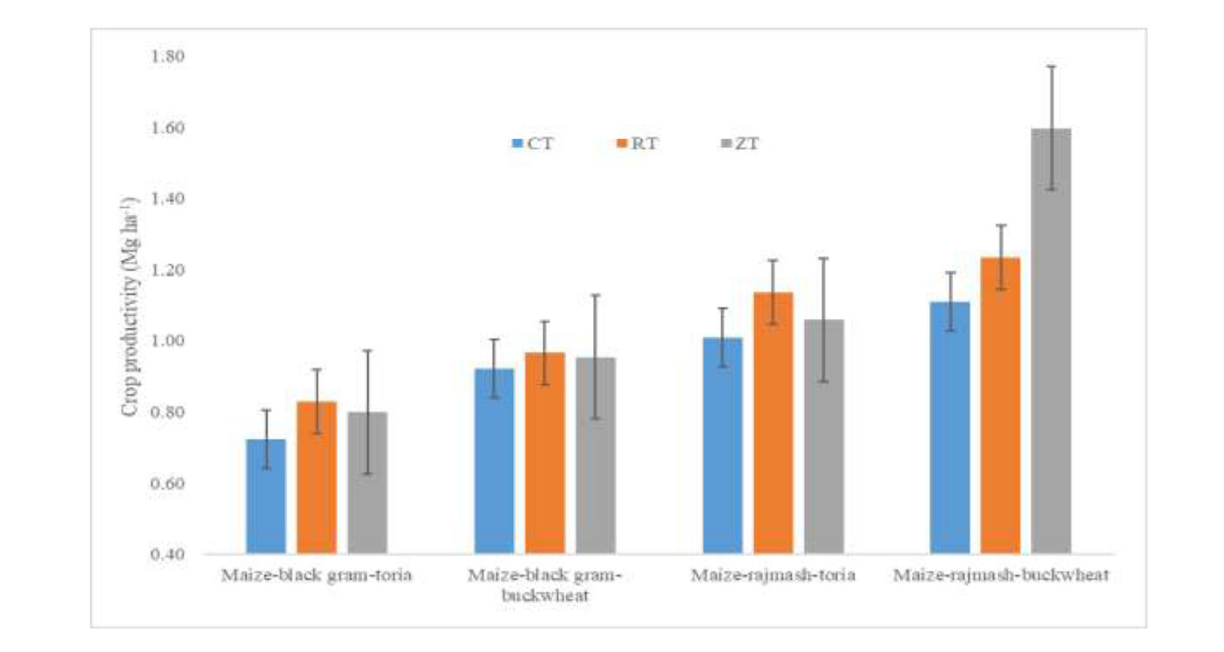
FIGURE2 Interactive effect of tillage and diversified cropping on the productivity of late rainy season crops. CT, conventional tillage; RT, reduced tillage; ZT, zero tillage. Error bar indicates the least significant difference (LSD) values at p =